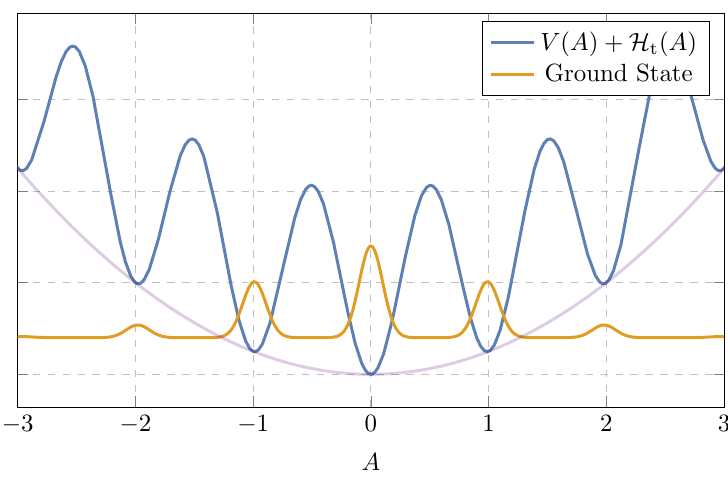
Figure 6. The gauge frame potential is a sum of a periodic potential V ( A ) and a harmonic potential (light purple). For strong periodic potentials, the ground state is roughly a sum of H t Gaussian peaks, centered about the minima of each well, with an overall Gaussian